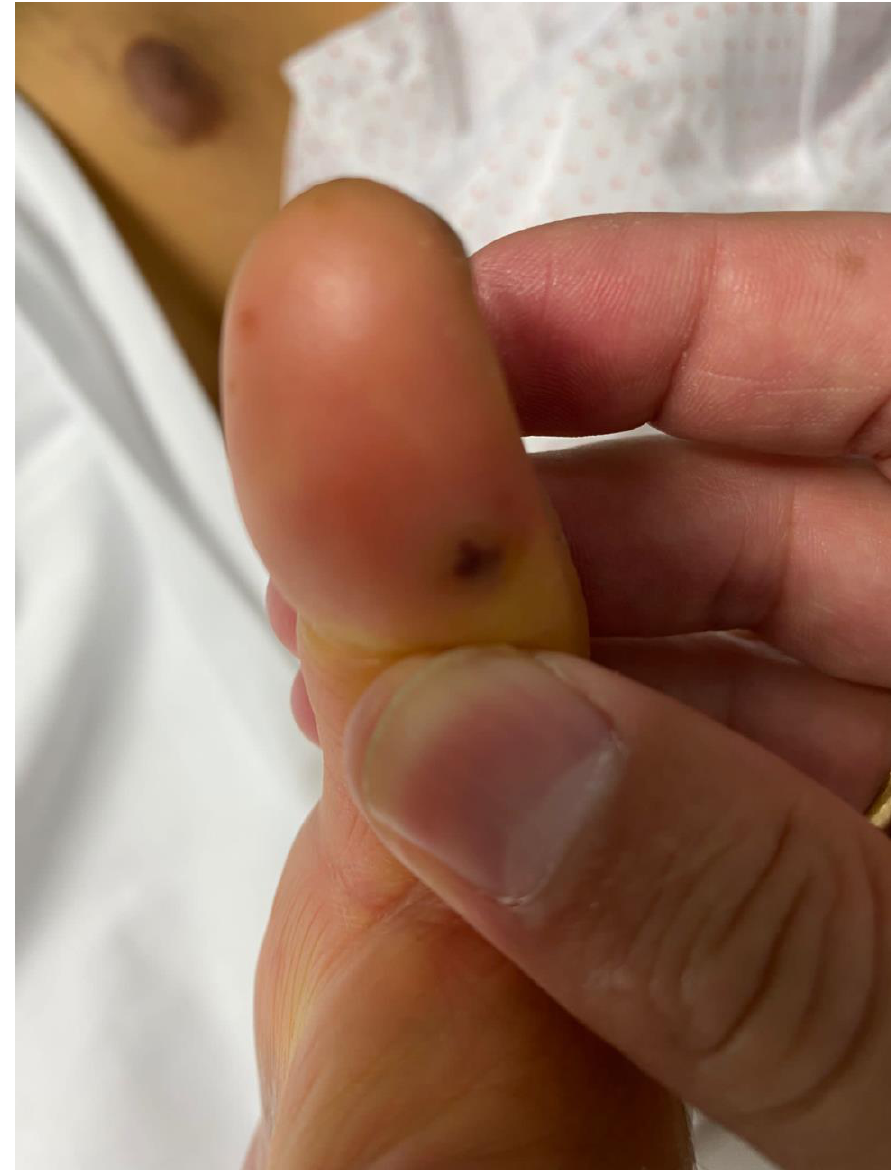
Figure 1. Janeway lesions in a 15-year-old adolescent with aortic valve infective endocarditis: hemorrhagic macules of the palms and soles that are due to septic emboli.